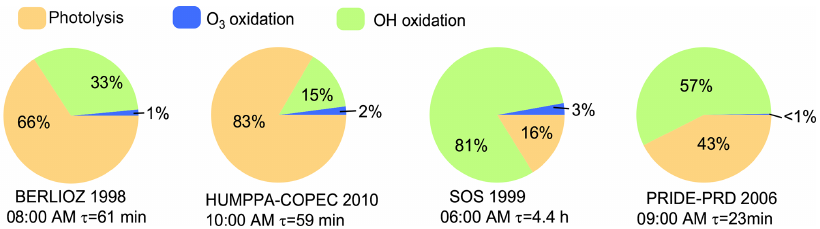
Figure 9. The relative contributions of photolysis (orange), OH oxidation (green), and O 3 oxidation (blue) to the photochemical decay of the nitrooxy enal, calculated based on measured OH and O 3 concentrations for the following field studies: BERLIOZ 1998 study in Pabstthum, Germany (Mihelcic et al., 2003; Platt et al., 2002); HUMPPA-COPEC 2010 study in Hyytiälä (Hens et al., 2014), Finland; SOS 1999 study in Nashville, USA (Martinez et al., 2003; Roberts et al., 2002); and PRIDE-PRD 2006 study in Guangzhou, China (Lu et al., 2012).